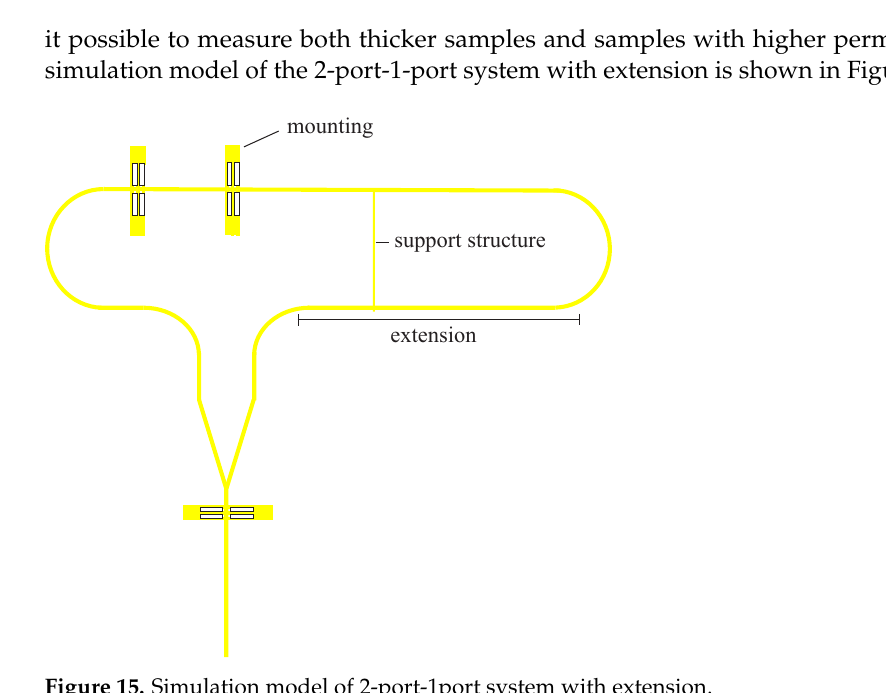
Figure 15. Simulation model of 2-port-1port system with extension.